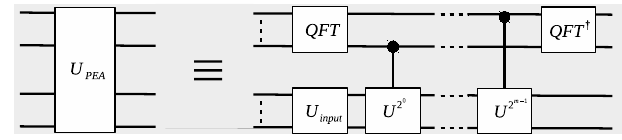
Figure 1: The phase estimation part of the